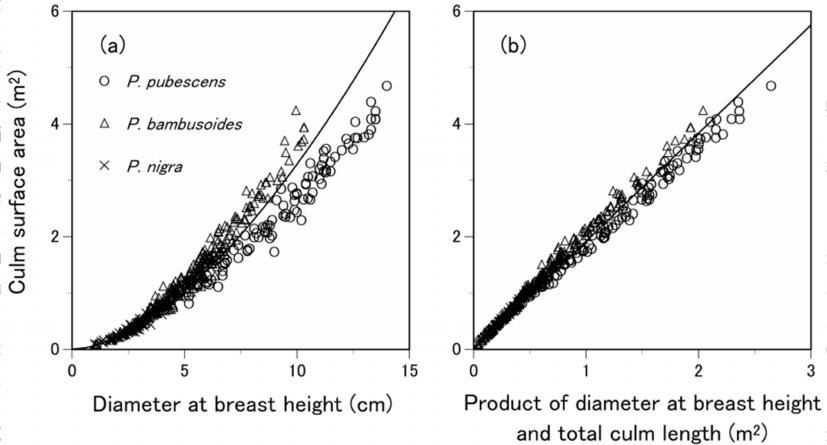
Figure 6. Relationships of culm surface area to ( a ) diameter at breast height and ( b ) product of diameter at breast height and total culm length for three Phyllostachys species. The solid lines represent the power and linear equations detailed in Table